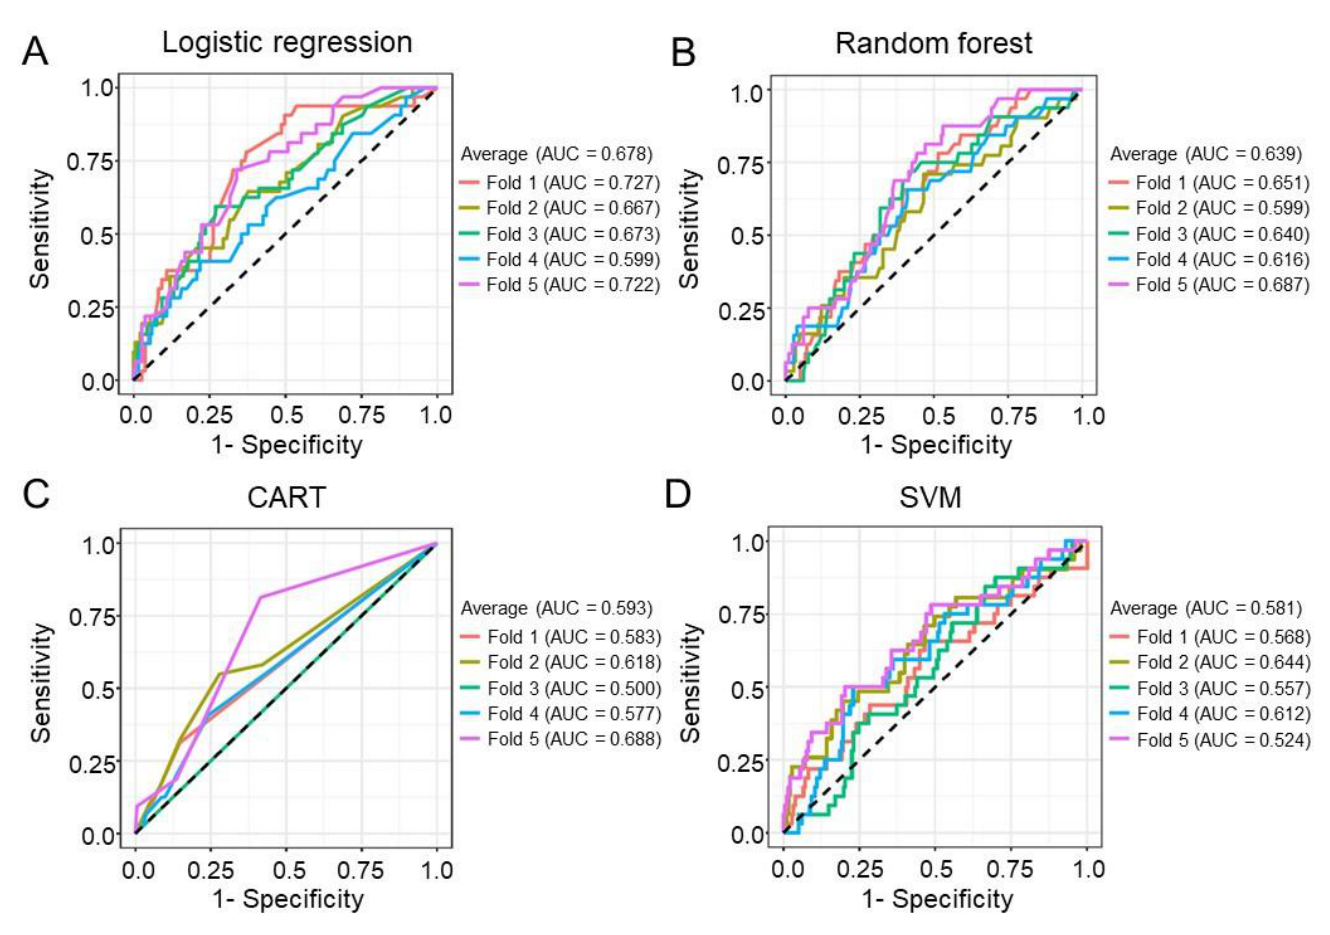
Figure 1. Prediction model with stratified five-fold cross-validation for cancer recurrence. ( A ) A logistic regression model was used to predict cancer recurrence with the highest average area under the curve (AUC) = 0.678. ( B ) A random forest model was used to predict cancer recurrence with an average AUC = 0.639. ( C ) Classification and regression decision trees (CARTs) were used to predict cancer recurrence with an average AUC = 0.593. ( D ) A support vector machine (SVM) was used to predict cancer recurrence with an average AUC = 0.581. Table 2. Univariable and multivariable analyses of variables associated with the probability of cancer